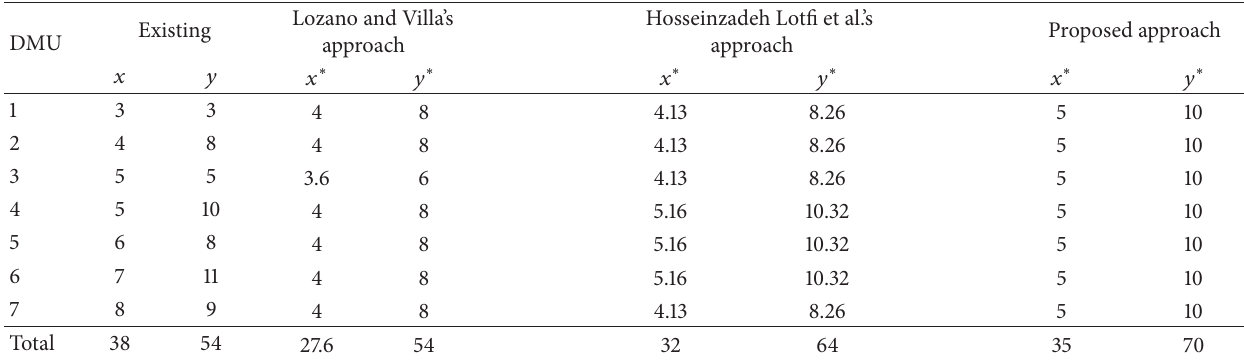
Table 3: Data and results of the seven DMUs with one-input and one-output .